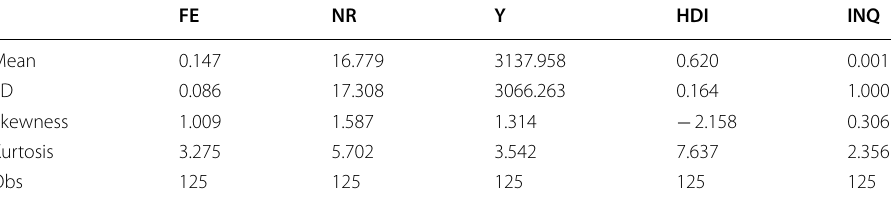
Table 6 Descriptive